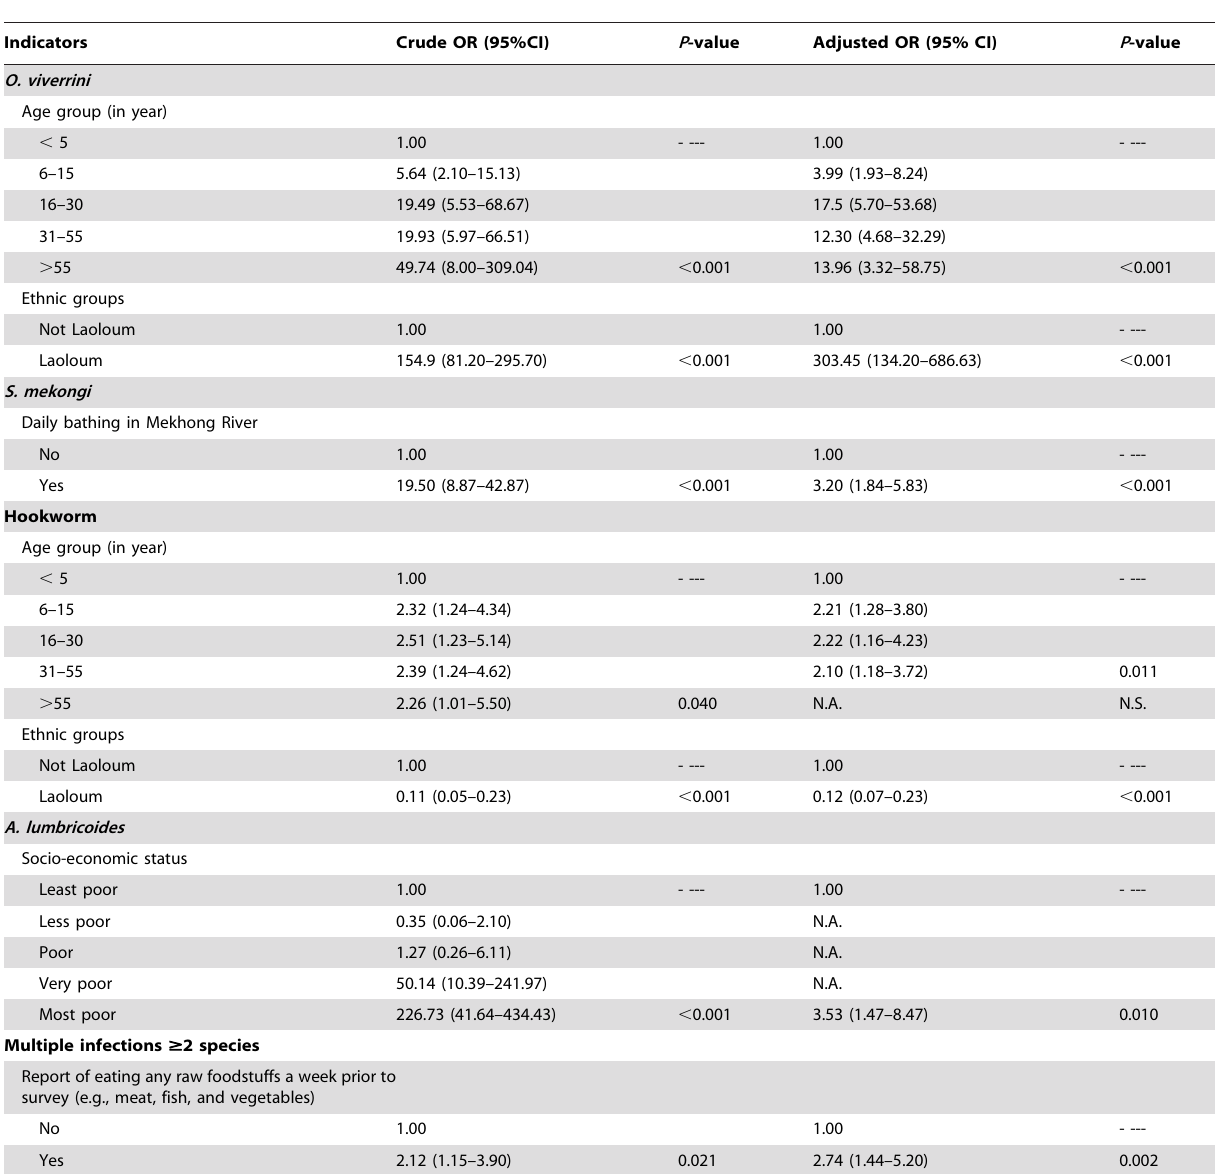
Table 4. Associations between parasitic infections and risk factors in Champasack (random household effect included, n